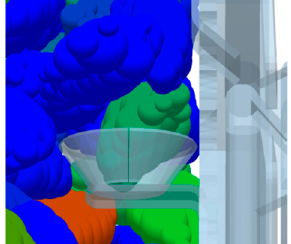
Figure 12. Vertical unstable state.